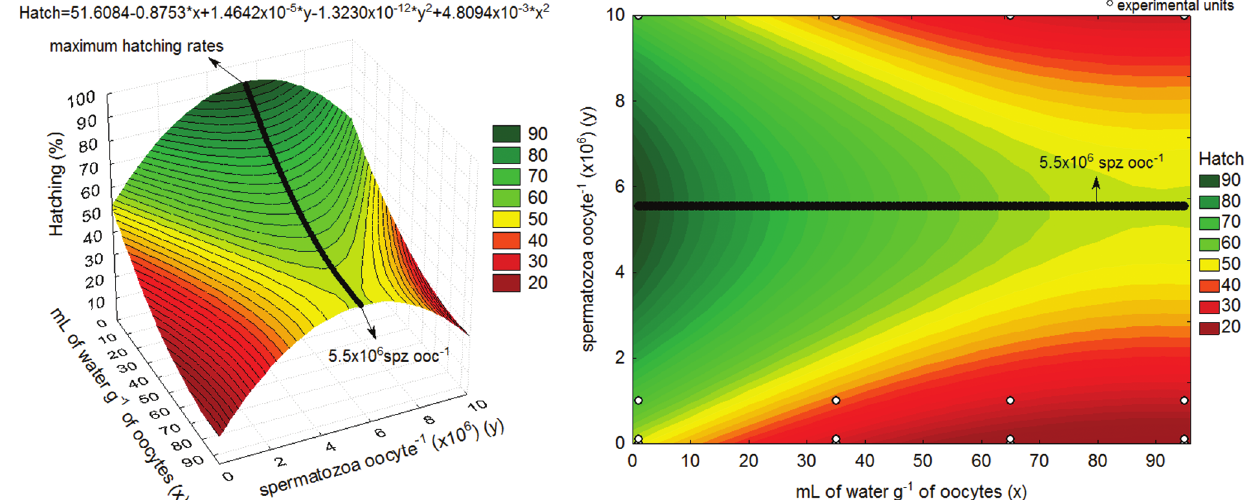
Fig. 2. Values of hatching rate (Hatch) of Steindachneridion parahybae with regard to different inseminating doses versus water volume. Left – 3D graphical representation. Right – 2D graphical representation. Spermatozoa oocytes -1 (spz ooc -1